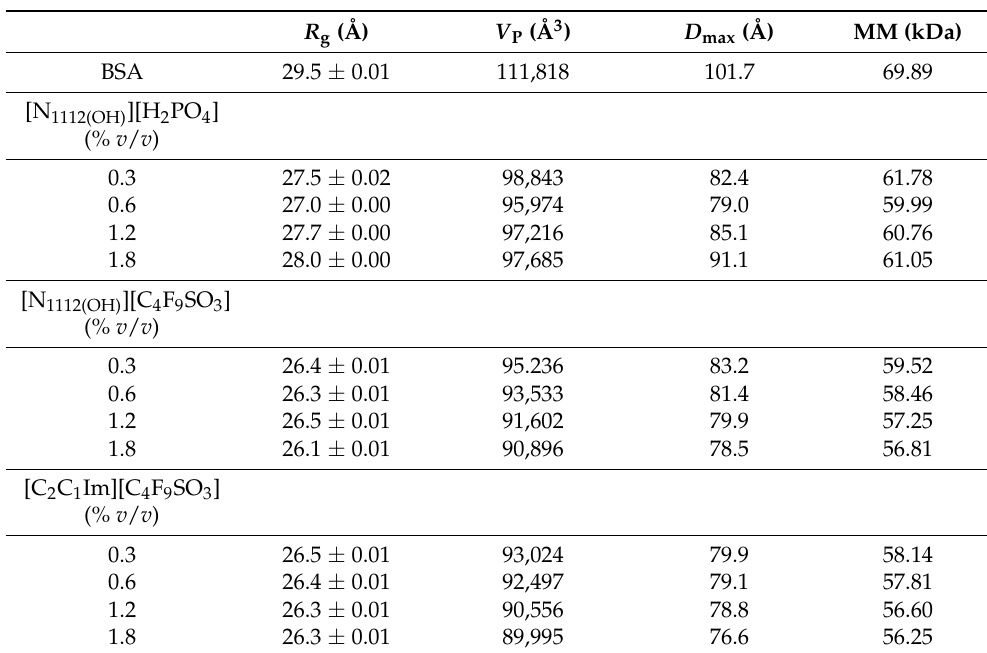
Table 4. SAXS structural parameters of BSA in the absence and presence of ILs.